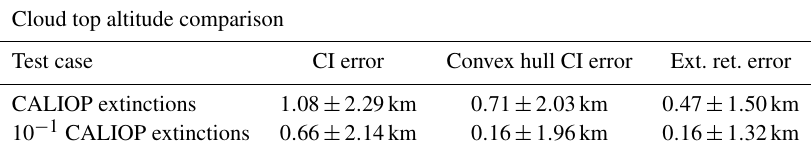
Table 1. This table aggregates the difference between true cloud top altitude and determined cloud top altitude for 440 CALIOP orbits acquired in December 2012 for simulated IRLS